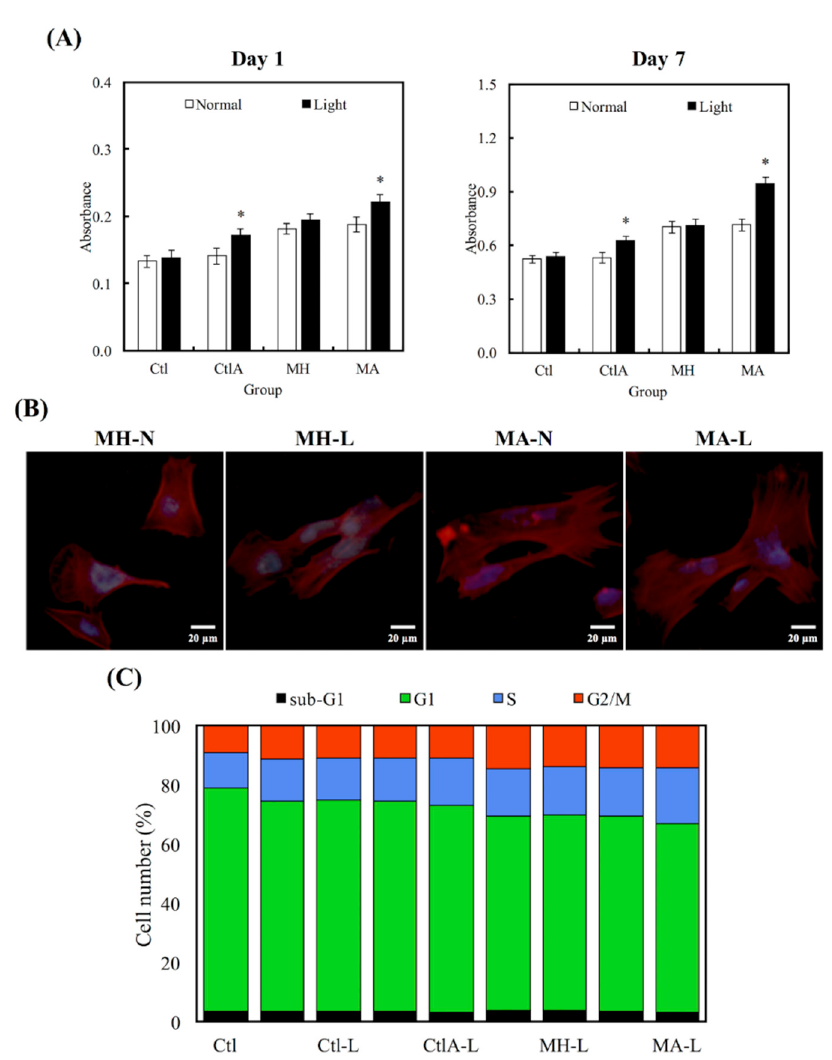
Figure 3. ( A ) Human dental pulp cells (hDPCs) proliferation assay cultured on different specimens at days 1 and 7. “*”, with a statistically significant difference ( p < 0.05) from Ctl. ( B ) DAPI immunofluorescence images of cell nucleus (blue) and F-actin (red) of hDPCs on non-light treated MTA cements (MH-N and MA-N) and on light-treated MTA cements (MH-L and MA-L) after 1 day of culture. ( C ) The percentages of each cell cycle phase after a day of culture on Ctl, light-treated Ctl with normal medium and ALA-contained medium (Ctl-L and CtlA-L) and light-treated MTA groups (MH-L and MA-L), determined using flow cytometry.